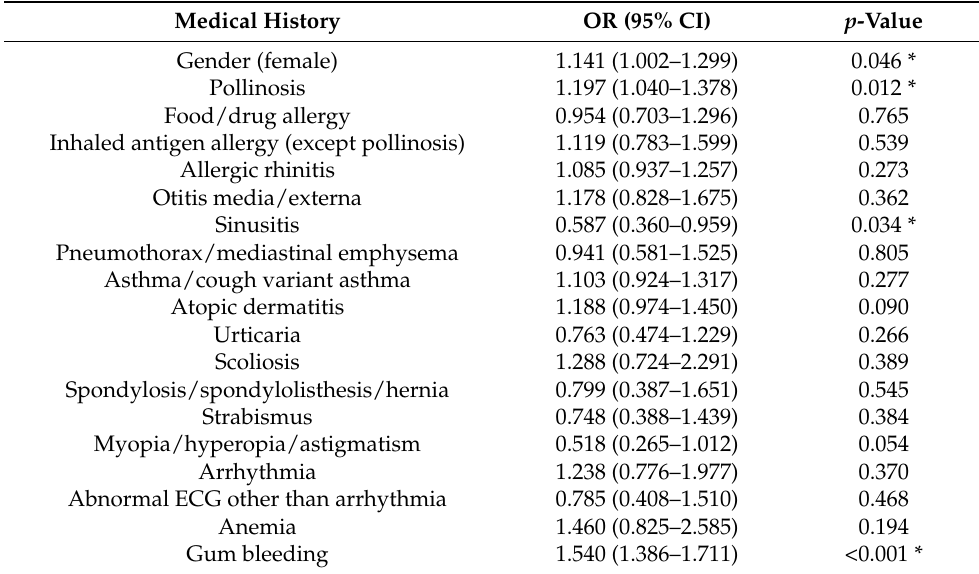
Table 3. Multivariate analysis for the association of awareness of teeth-alignment disorder with medical